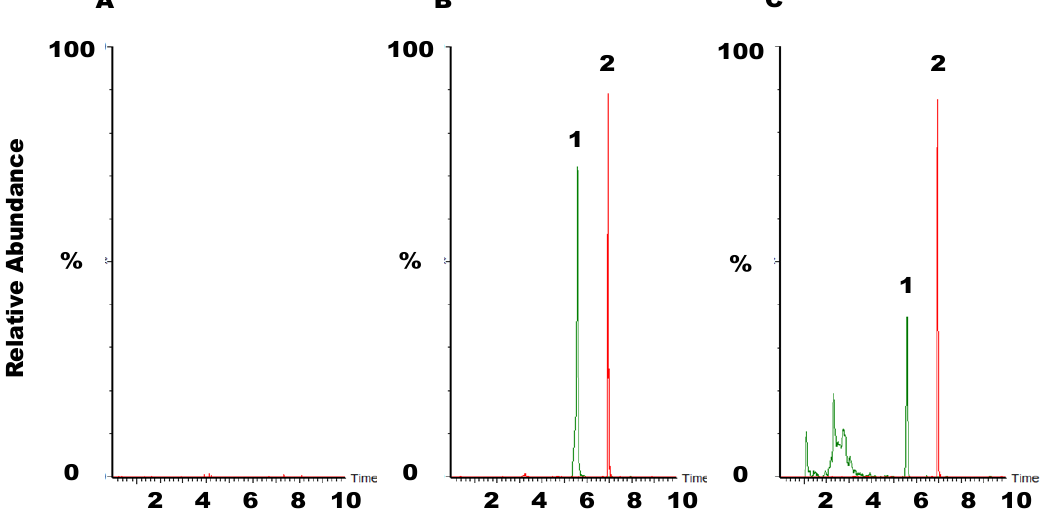
Figure 3. Representative UPLC-MS/MS chromatograms of: ( A ) blank rat plasma sample; ( B ) blank rat plasma sample spiked with rhein (2500 ng/mL) and IS (2500 ng/mL); ( C ) rat plasma sample containing rhein (869 ng/mL) collected at 90 min after SHXXT administration (5 g/kg, p.o.). 1: rhein (retention time: 5.57 min); 2: ibuprofen (IS, 2500 ng/mL, retention time: 6.95